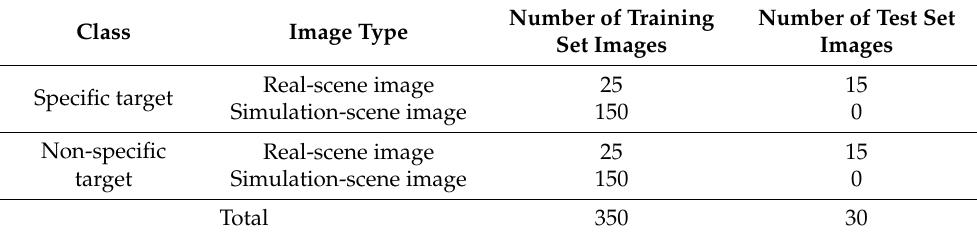
Table 2. Setting of the mixed-scene ship dataset.